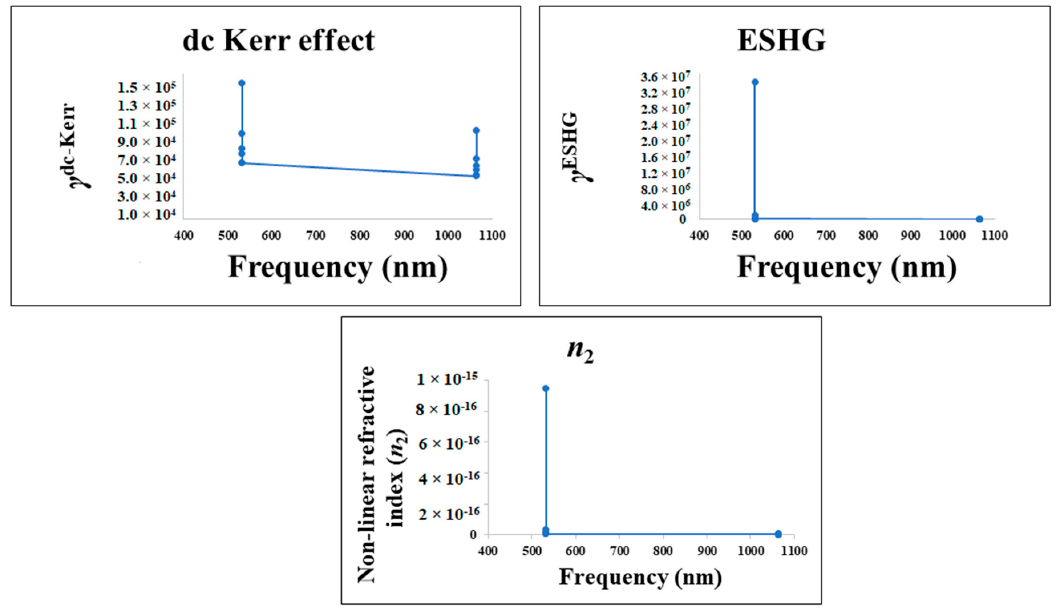
Figure 3. Graphical representations of dc-Kerr, ESHG coefficients, and refractive index for compounds ( 5a – f ) at different wavelengths (532 and 1064 nm).